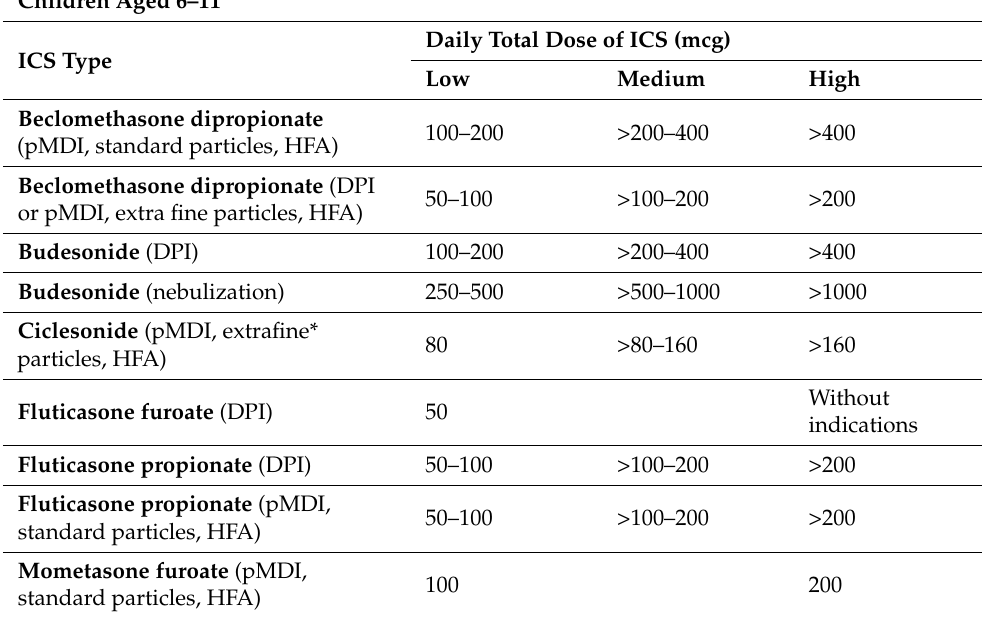
Table 4. Daily total dose of ICS recommended to children aged 6–11 for asthma treatment based on GINA 2022